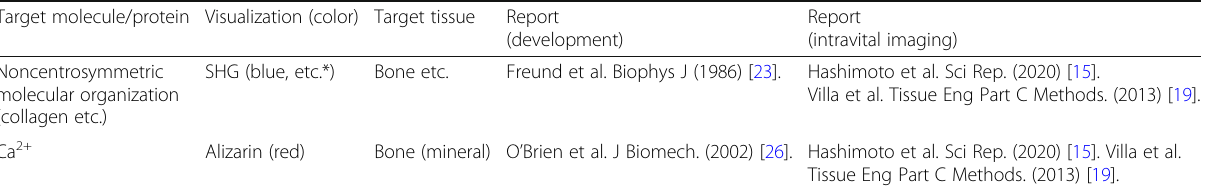
Report (intravital imaging)